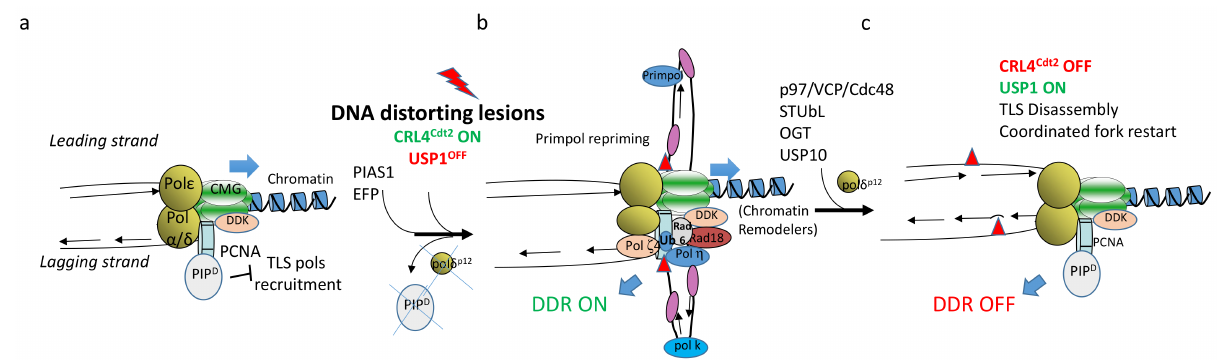
Figure 1. Factors mediating Rad18 recruitment. ( a ) Recruitment of Rad52, NBS1 and the RFWD3 ubiquitin ligase occurs onto Figure 2. Speculative model of translesion synthesis (TLS) pol recruitment at replication forks stalled by DNA distorting ssDNA via replication protein A (RPA). Rad52 and NBS1 may bridge the interaction between RPA and Rad18, while RFWD3 lesions. ( a ) When the replisome encounters DNA distorting lesions (red triangles), replicative polymerases (Pol α , δ , ε ) might non-specifically polyubiquitinate proteins bound to ssDNA (question mark), thus facilitating TLS factor nucleation. are stalled, while the replicative helicase (CMG complex) can slide through. This process generates an excess of ssDNA ( b ) The SART3 pre-mRNA splicing factor may facilitate chromatin remodeling and PCNA mUb through interaction with ( b ). Discontinuous DNA synthesis continues on the lagging strand, which generates small replication intermediates that prime the recruitment of specific checkpoint factors leading to activation of the ATR-dependent checkpoint (DDR, not Rad18 and Pol η when replication forks encounter transcription units (RNA pol2). RNA–DNA hybrids with displaced shown). TLS Pol κ is recruited onto these replication intermediates to stabilize them and facilitate ATR signaling through ssDNA (R-loops) may also be generated in this situation, and thus promote RPA and Rad18 recruitment. ( c ) DNA–protein Chk1 phosphorylation [38]. DDR activation activates the CRL4 Cdt2 ubiquitin ligase, which induces PCNA-dependent crosslinks (DPC) stimulate recruitment of the Spartan metalloprotease through interaction with PCNA. Spartan recruitment PIP degron-containing proteins destruction, such as the p12 subunit of the Pol δ holoenzyme. This process facilitates will facilitate Rad18 recruitment and PCNA mUb Pol ζ 4 complex recruitment into the Pol δ holoenzyme to position it for bypass extension. Recruitment of RPA onto ssDNA brings about Primpol and other factors (see Figure 1). Primpol allows repriming on the leading strand. Rad18 binding is also stabilized by interaction with Pol η and DDK. The Rad6/Rad18 complex then catalyzes PCNA mUb , thus stabilizing interaction of Pol η (and/or other Y-family TLS pols) with PCNA. Pol η poly-SUMO modification by PIAS1 and PCNA ISGYlation by the ISG15 (E3) ligase EPF also occurs at this stage. Following this step, the lesion is b-bypassed by the sequential action of Pol η and Pol ζ (insertion and extension, respectively). Upon lesion bypass, Pol η is polyubiquitinated by CRL4 Cdt2 , OGTylated, and extracted from chromatin by the p97/VPC/Segregase complex to be targeted for proteasomal degradation, while PCNA is deubiquitinated by the concerted action of USP1 and USP10, thus leading to disassembly of the TLS complex including Rad18 ( c ). The Ubr5 ubiquitin ligase is also implicated in this step by mediating Pol η chromatin binding through the ubiquitination of histone H2B [39]. Finally, inactivation of CRL4 Cdt2 and stabilization of the ubiquitin hydrolase USP1 resets PCNA, to a DNA replication-competent form followed by TLS Pol degradation and/or release, thus allowing fork restart. 2.3. Rad18 Chromatin Recruitment Since the initial observation that Rad6/Rad18 promotes PCNA mUb [40], several other factors have also been reported to contribute to this reaction, although their relationship with recruitment of the Rad6/Rad18 complex at stalled replication forks has not always been clarified. Amongst the factors directly or indirectly implicated in recruitment of this complex to arrested forks, the first is ssDNA. Indeed, it was previously shown that replication fork uncoupling is important to induce PCNA mUb [41]. Although Rad18 was originally shown to have affinity for ssDNA [42], previous [43] and more recent studies [44,45] propose that RPA also contributes to Rad18 recruitment. More investigations are required to clearly establish whether a physical complex between RPA and Rad6/Rad18 in vivo can be observed and whether RPA binding to ssDNA at stalled forks can recruit this complex. The Claspin component of the fork protection complex was also reported to be important for PCNA mUb [46], probably by coordinating the replicative helicase with PCNA and mediating the interaction between PCNA and Rad18. The pre-mRNA splicing factor SART3 was also shown to be important to mediate Rad18–Pol η interactions, as well as to generate ssDNA following DNA damage [47]. A very recent report in the yeast Saccharomyces cerevisiae proposes that the Rad52 protein, involved in homologous recombination, functions in stimulating PCNA mUb independently of its HR function, probably by regulating the recruitment of RPA onto ssDNA gaps [48].